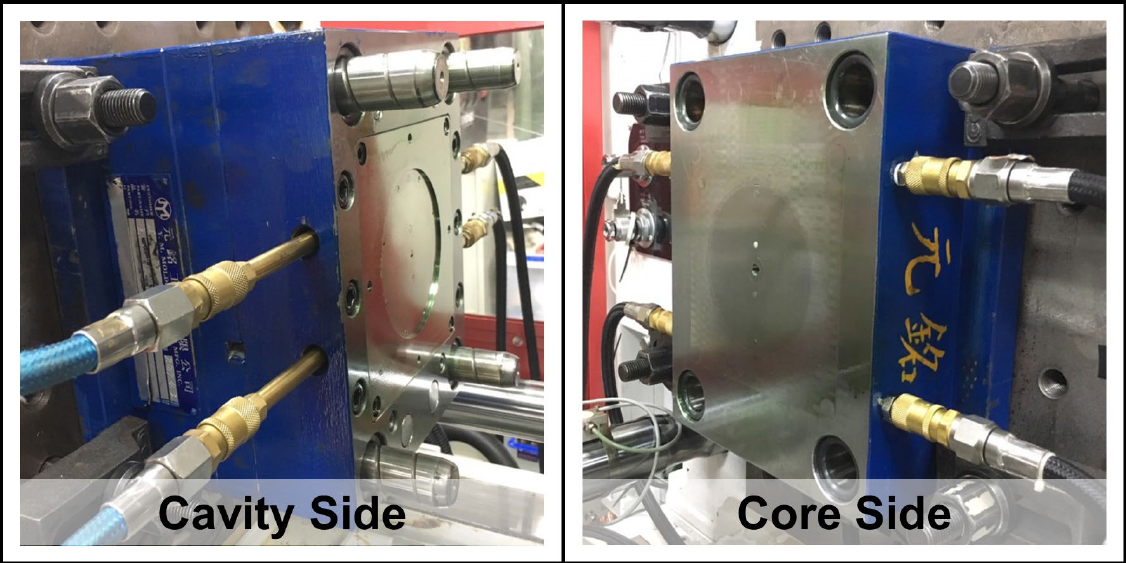
Figure 5. The mold of the round-shaped sample. Table 1 shows the injection parameters; the temperature profile along the